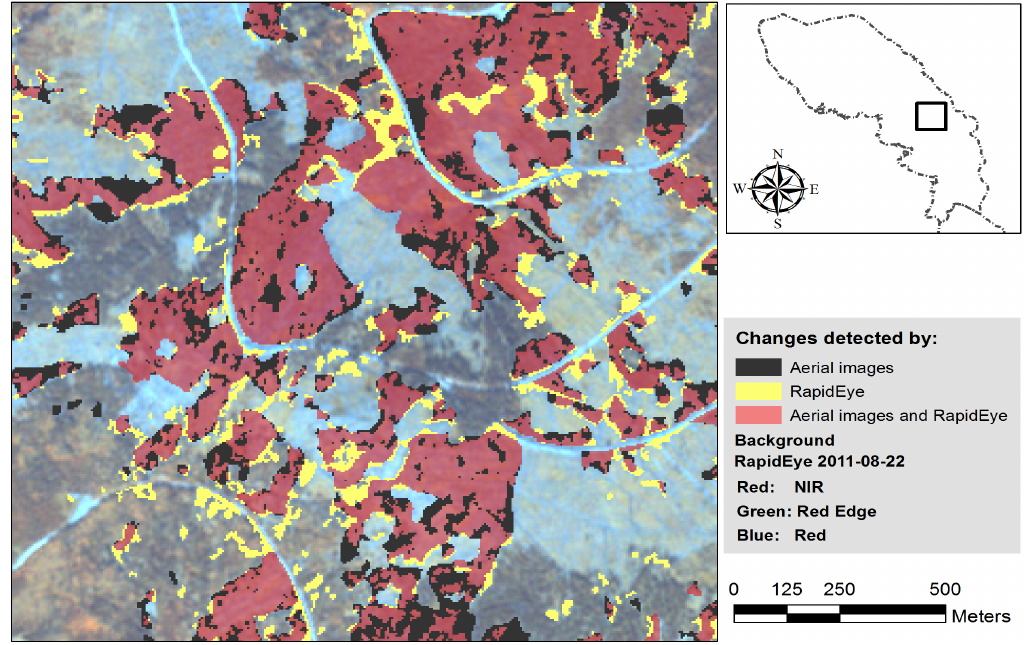
Figure 7. Example showing the forest cover losses that were detected only when using aerial image interpretation, those which were detected only when RapidEye data was used and those which were detected using both